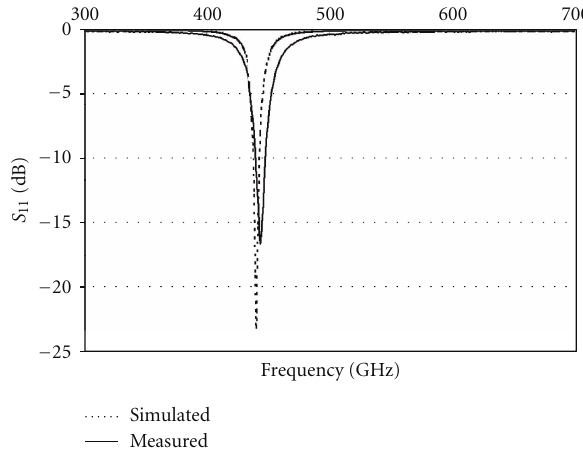
Figure 7: S 11 coe ffi cient (dotted lines: HFSS simulation, solid lines: measurement) for 25 Ω access.